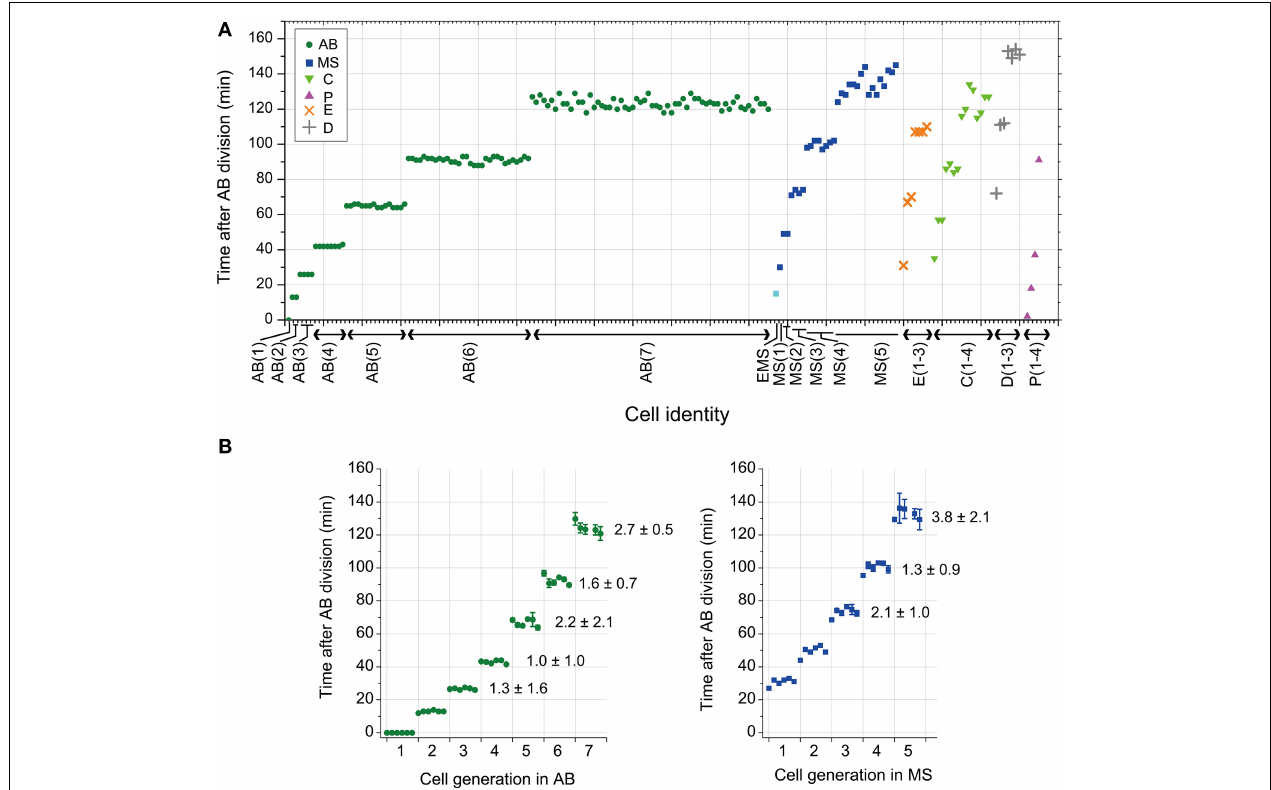
FIGURE 1 | Cell division timing of C. elegans embryos. (A) The cell division timings in an embryo cultured at 25 ◦ C. Cell identity is indicated on the horizontal axis. Cell division timing was determined by nuclear envelope breakdown (NEBD). The numbers in parentheses indicate the cell generation in each founder cell lineage. For example, AB(1) indicates the AB cell, and AB(2) indicates the AB daughter cells. (B) The average and standard deviation (SD) of cell division timings in the same generation in AB and MS lineages in an embryo were obtained; data obtained from six embryos were aligned on